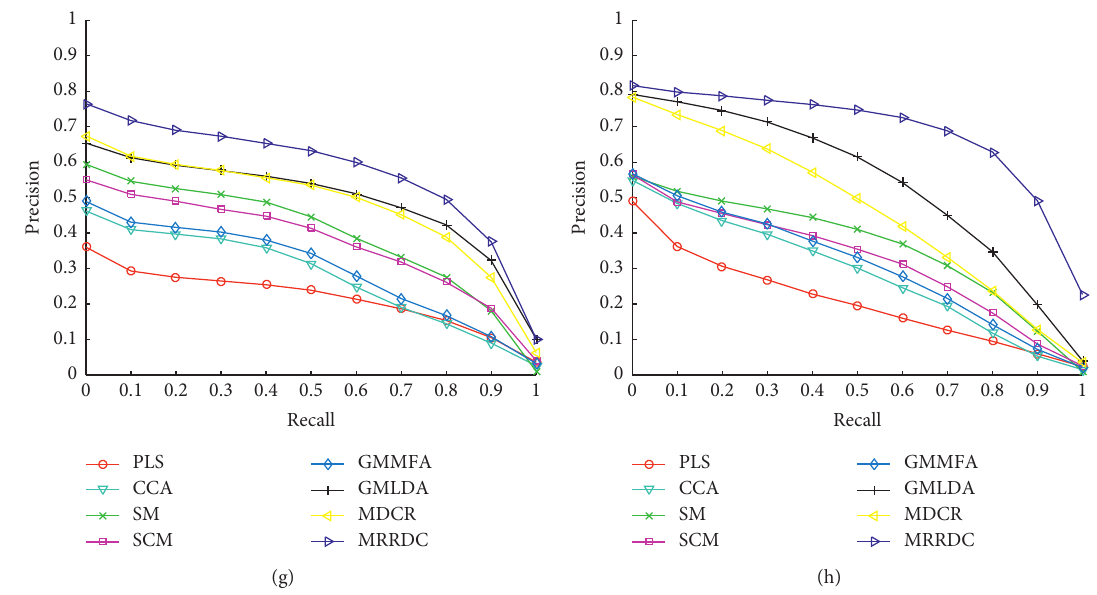
Figure 3: Precision-recall curves of the proposed MRRDC and compared methods. (a) I2Ton wiki-R. (b) T2I on wiki-R. (c) I2Ton wiki-W. (d) T2I on wiki-W. (e) I2T on Pascal. (f) T2I on Pascal. (g) I2T on INRIA-Websearch. (h) T2I on INRIA-Websearch.